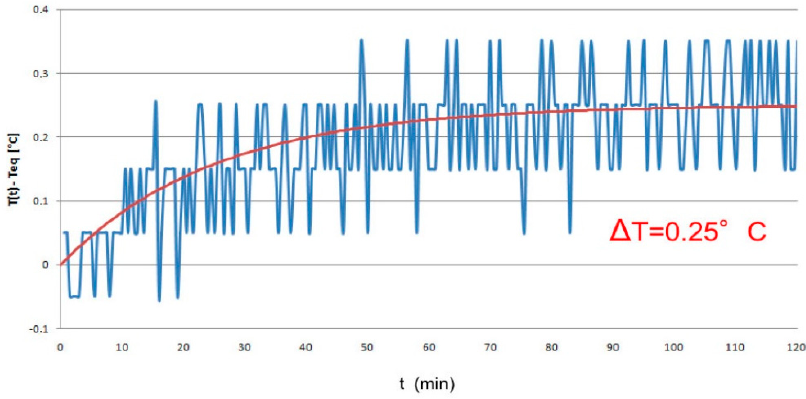
Figure 7. Temperature increase as a function of time. Measurement inside the biological sample during 2 h exposure to a CW at 2.45 GHz and 0.7 W/kg of SAR.